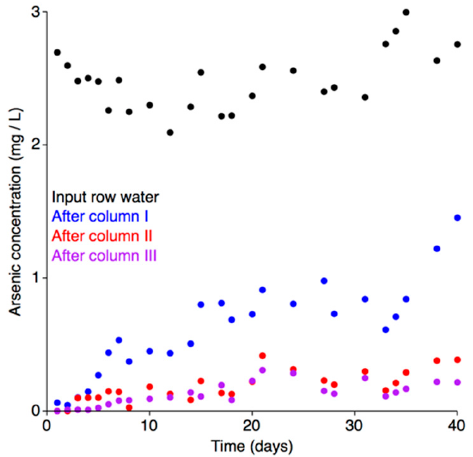
Figure 5. Arsenic adsorption breakthrough curves. The arsenic adsorption breakthrough curves for each column of the adsorption module are shown. Total arsenic concentrations in the raw water (black), and after column I (blue), column II (red), and column III (purple) are shown.